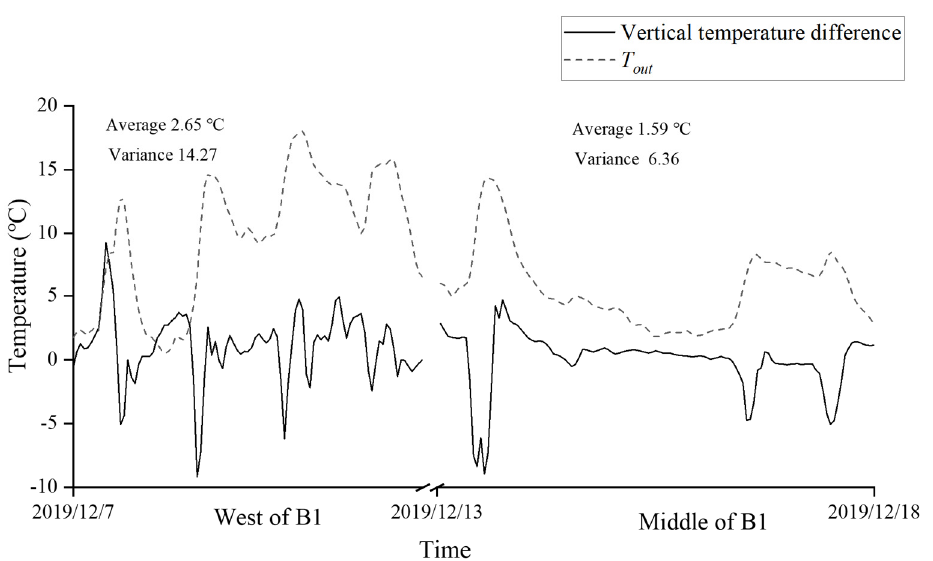
Figure 7. The vertical temperature difference of B1.